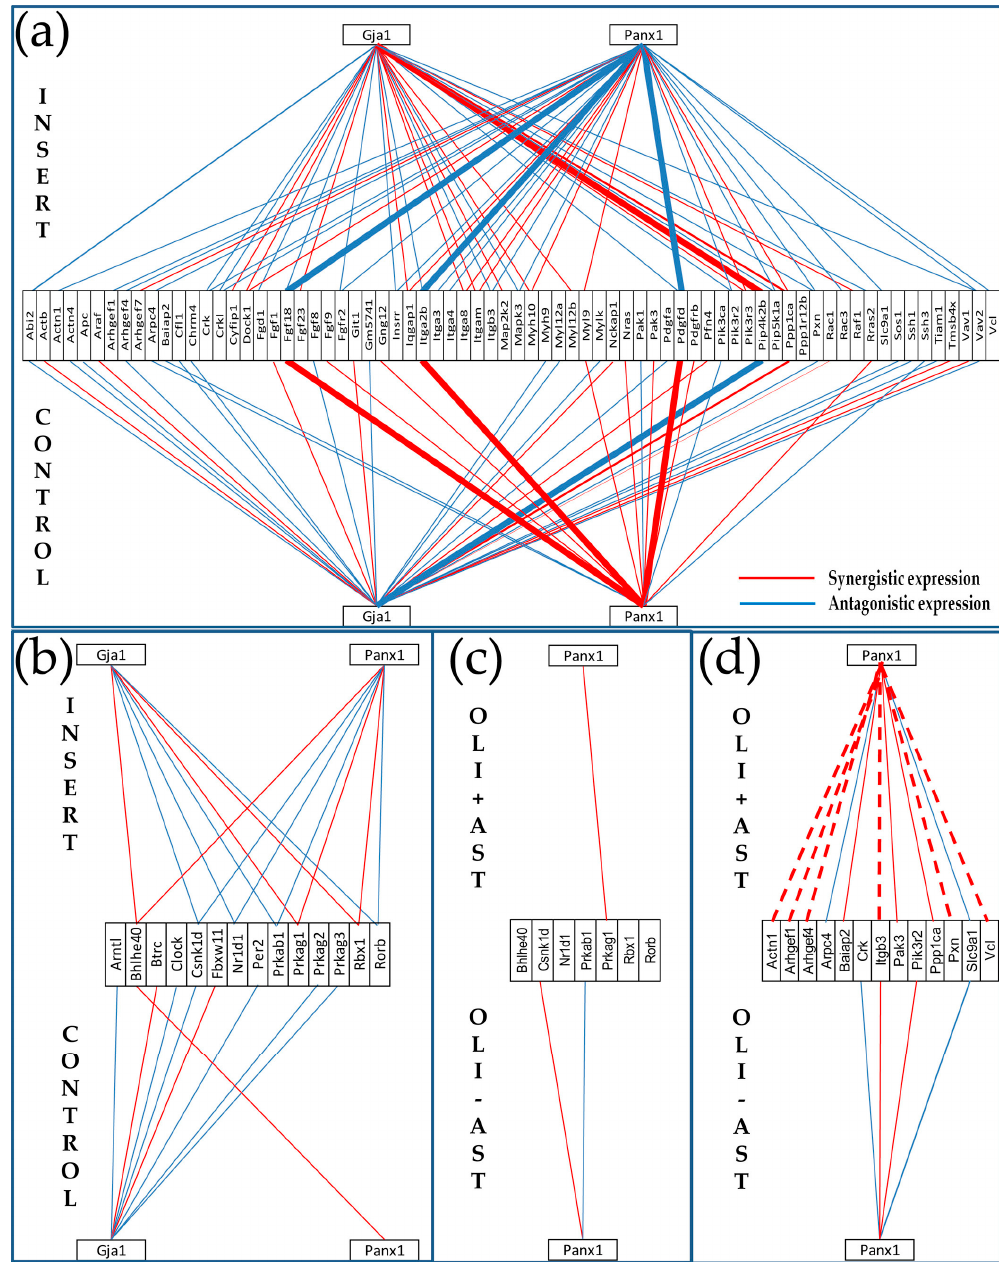
Figure 8. Topology of gene networks is sensitive to the cellular environment. ( a , b ) Proximity of non-touching olineu remodels the transcriptomic networks by which expression of genes encoding connexin43 ( Gja1 ) and pannexin1 ( Panx1 ) relate to the expression of ( a ) actin cytoskeleton and ( b ) circadian rhythm genes in astrocytes. ( c , d ) Proximity of non-touching astrocytes changes the expression coordination of Panx1 with ( c ) circadian rhythm and ( d ) actin cytoskeleton genes in Oli-neu . Thicker continuous lines in ( a ) indicate reversal type of coordination in astrocyte by oligodendrocyte proximity. Dashed lines in ( d ) indicate opposite coordination in astrocytes and oli neu when co-cultured. CONTROL / OLI-AST = astrocytes / Oli-neu cells cultured alone. INSERT / OLI + AST = co-culture of astrocytes and Oli-neu cells . Note: in order to simplify the illustration, only the Panx1 coordination partners from the two pathways in astrocytes are presented in the Oli-neu cells.